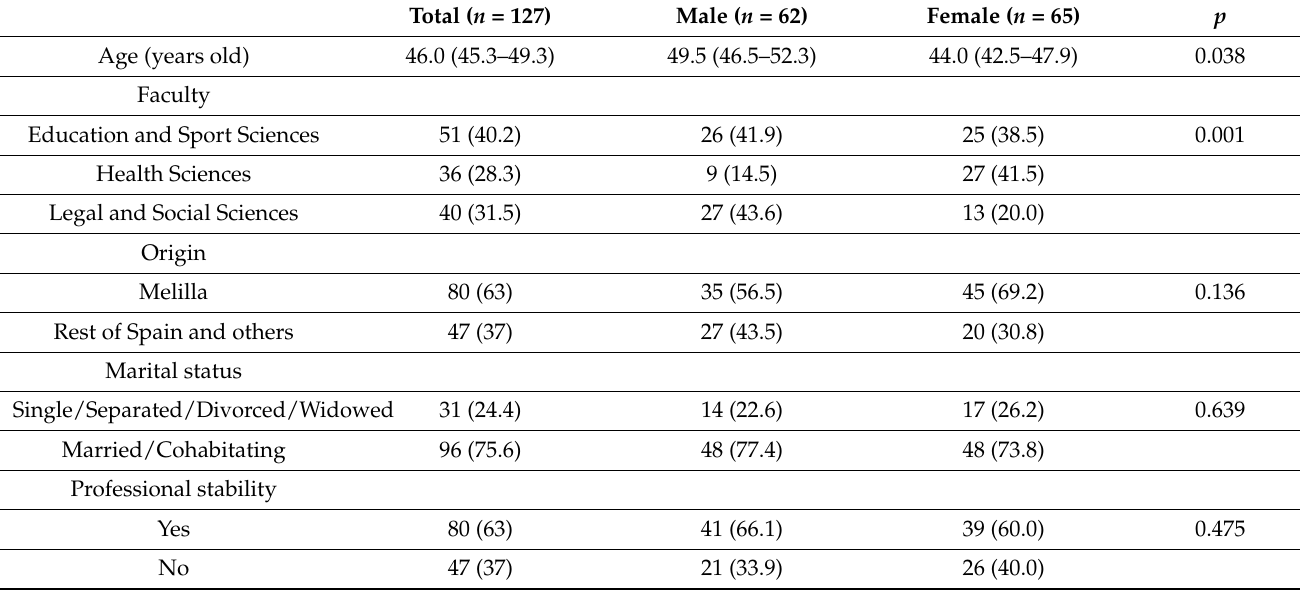
Table 1. Sociodemographic characteristics of university professors of the Melilla campus (University of Granada).